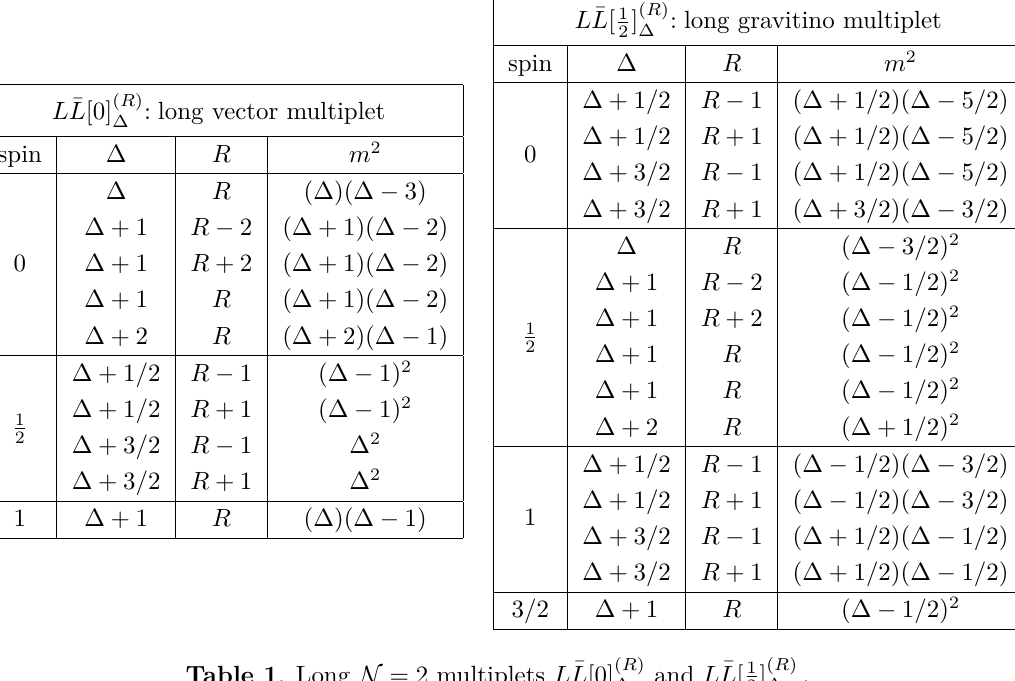
Table 1 . Long N = 2 multiplets L ¯ L [0] ( R )